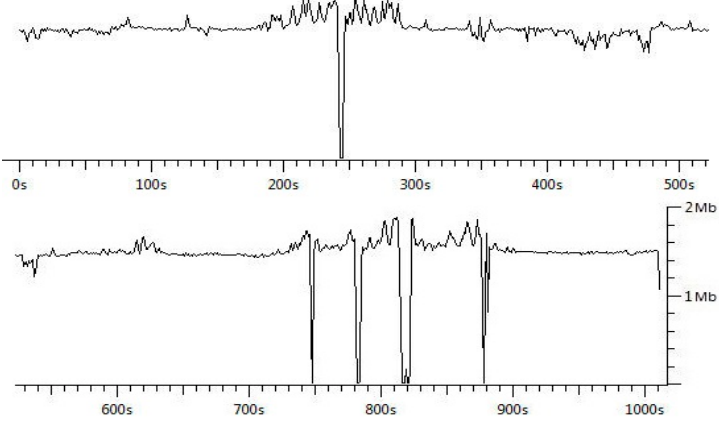
Figure 5. Data rate of vehicular networking using 5GTN.